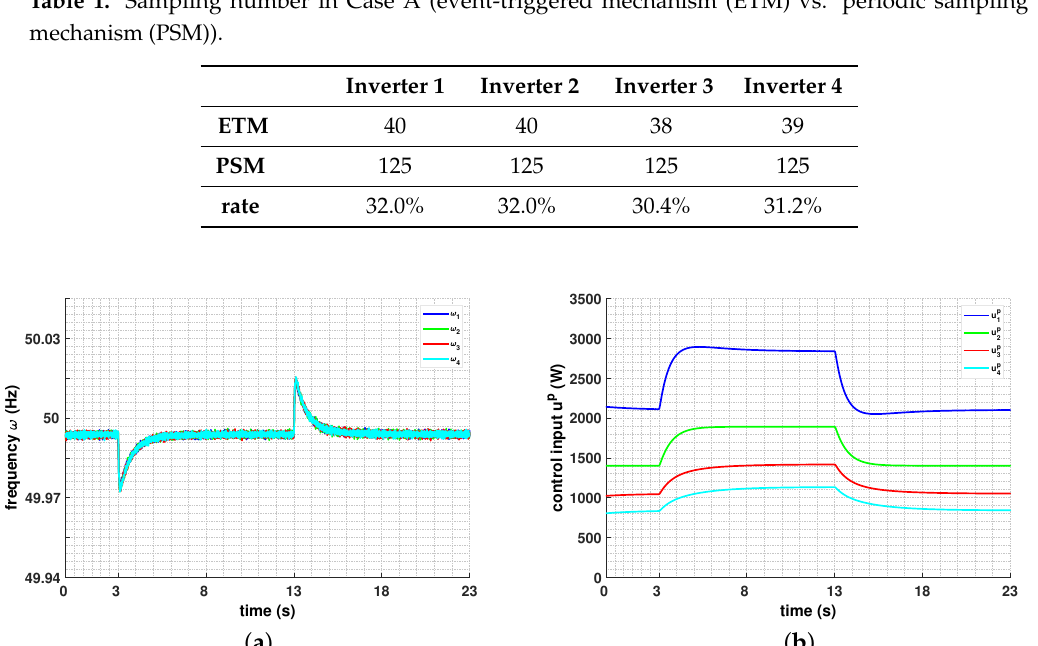
Figure 8. Responses of frequency and active power control input for periodic sampling mechanism in Case A. ( a ): Responses of frequency; ( b ): Responses of active power control input.